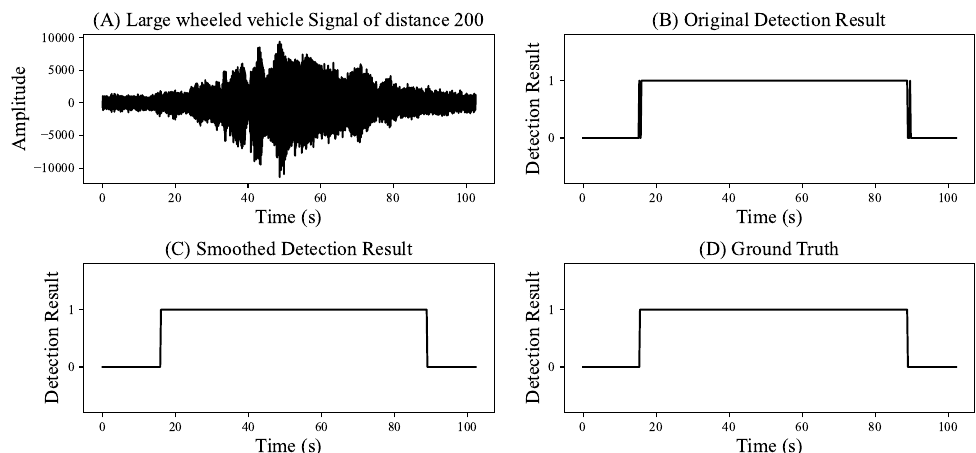
Figure 8. Example of the original signal of a recording and its detection results: ( A ) the original signal of a recording; ( B ) the detection result of the recording; ( C ) the smoothed result; ( D ) the detection ground